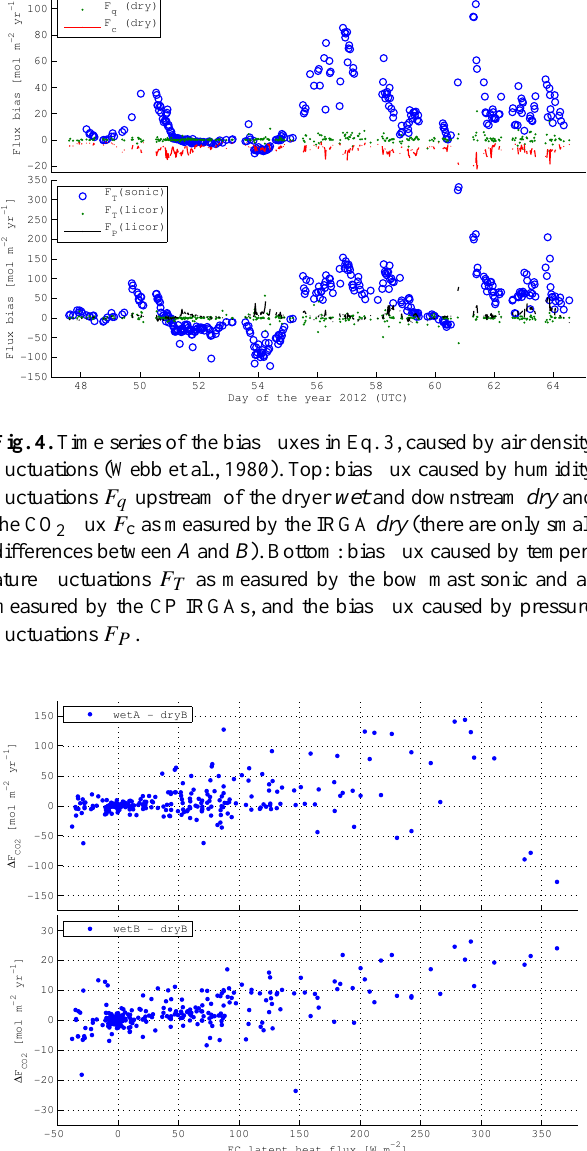
Fig. 5. Difference between the CO 2 flux calculated from the mea- sured signals x cm from the un-dried gas analysers to the flux from dryB as a function of the EC latent heat flux measurement from the un-dried gas analysers. Different scales are used for the two sub- plots.